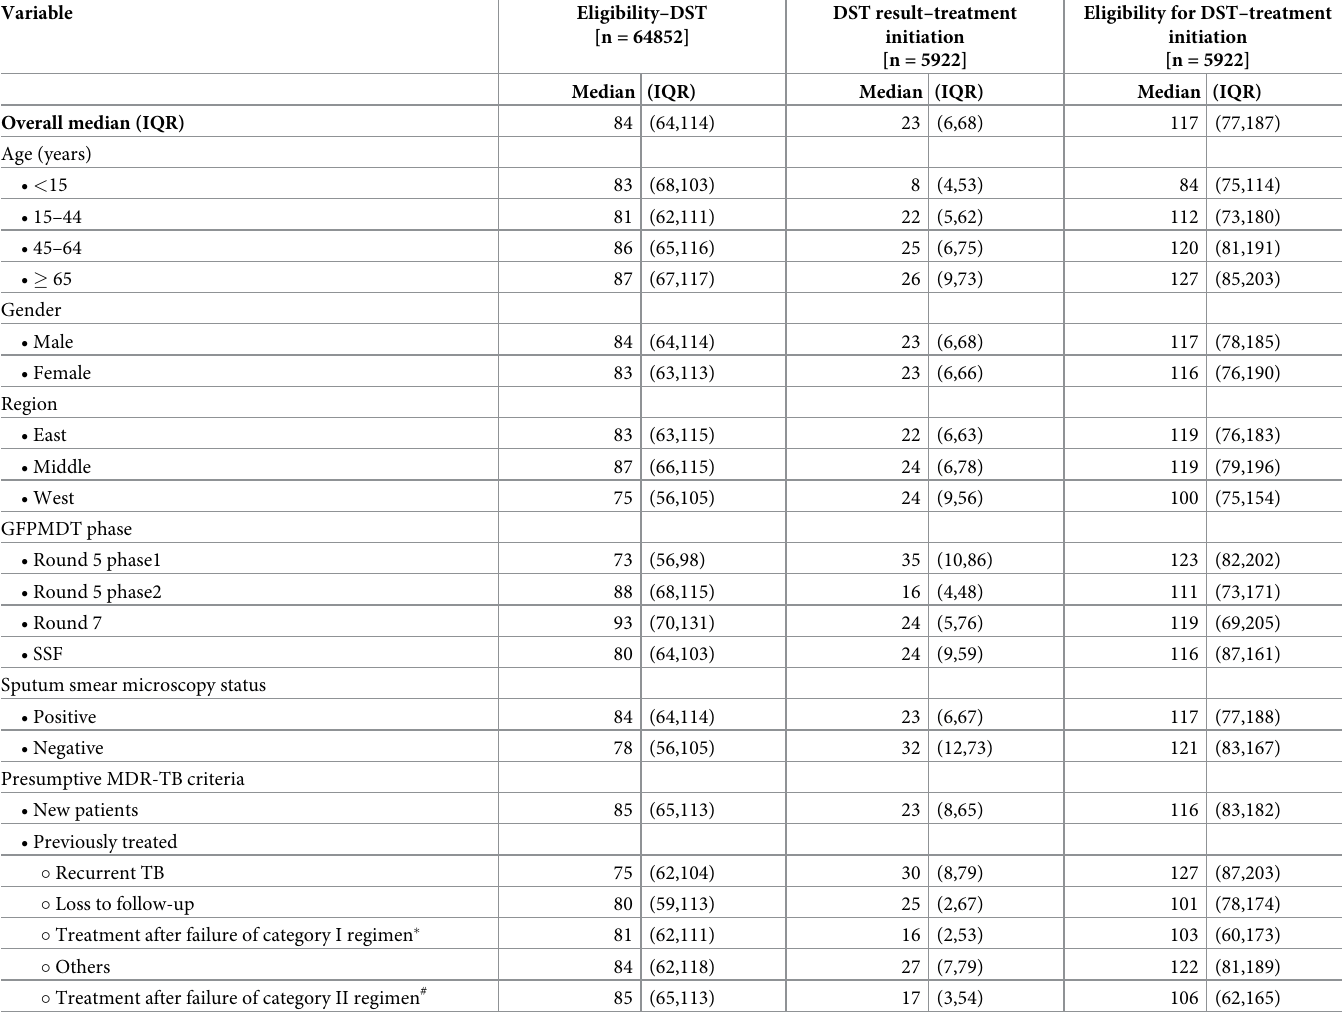
Table 3. Time taken (days) for procedures in testing / treatment of presumptive/confirmed MDR-TB patients under GFPMDT project in China, October 2006-June 2013.